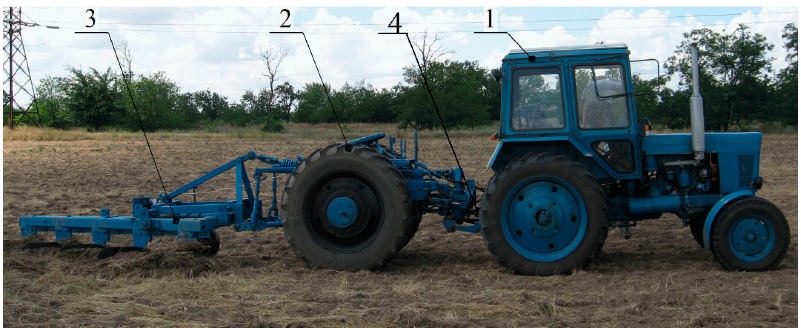
Figure 1. The machine-and-tractor aggregate of a modular type. 1—the power module (the wheeled tractor); 2—the technological module; 3—the aggregated agricultural machine (plough); 4—cardan transmission.